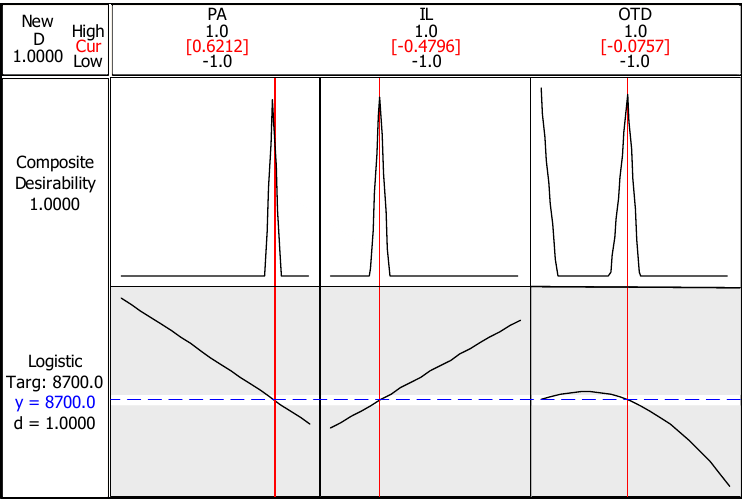
Figure 9. Logistics Cost Optimization Chart.